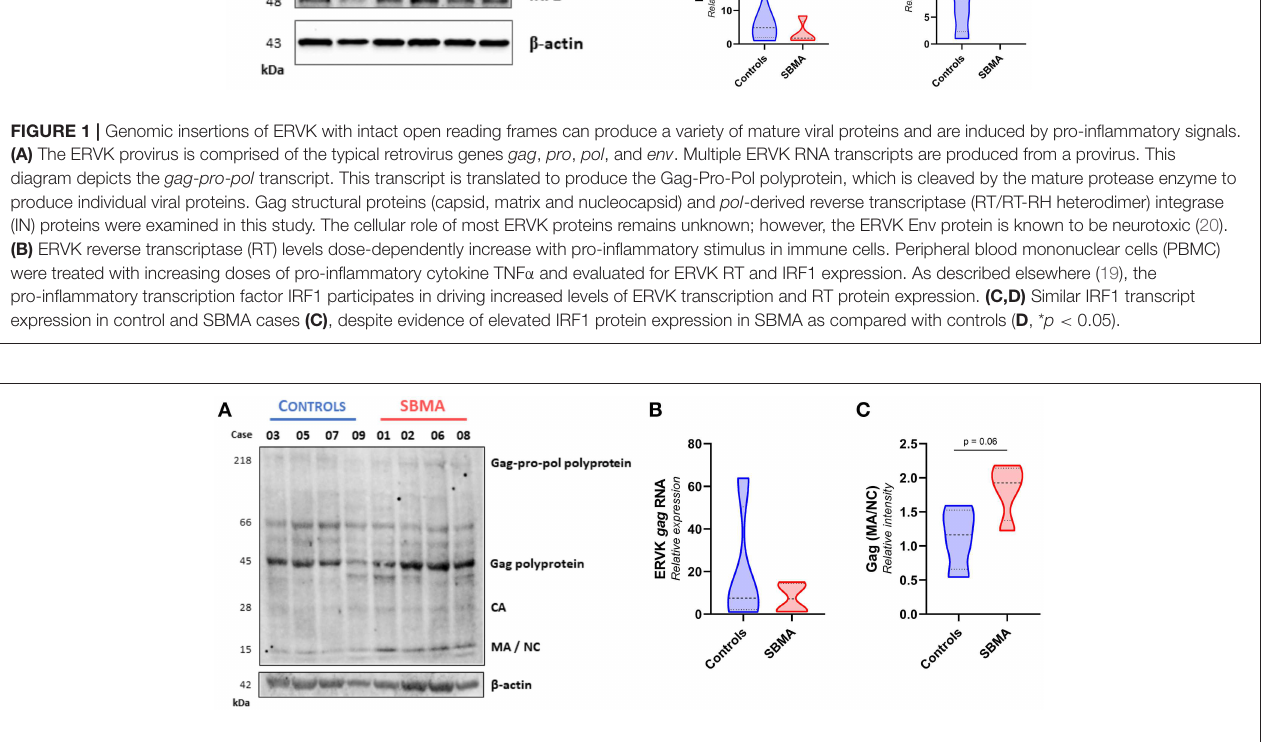
Together these data show that ERVK viral protein maturation is enhanced in SBMA PBMC, as compared with control cells. The implications of ERVK viral protein activity as it may relate to SBMA will be discussed